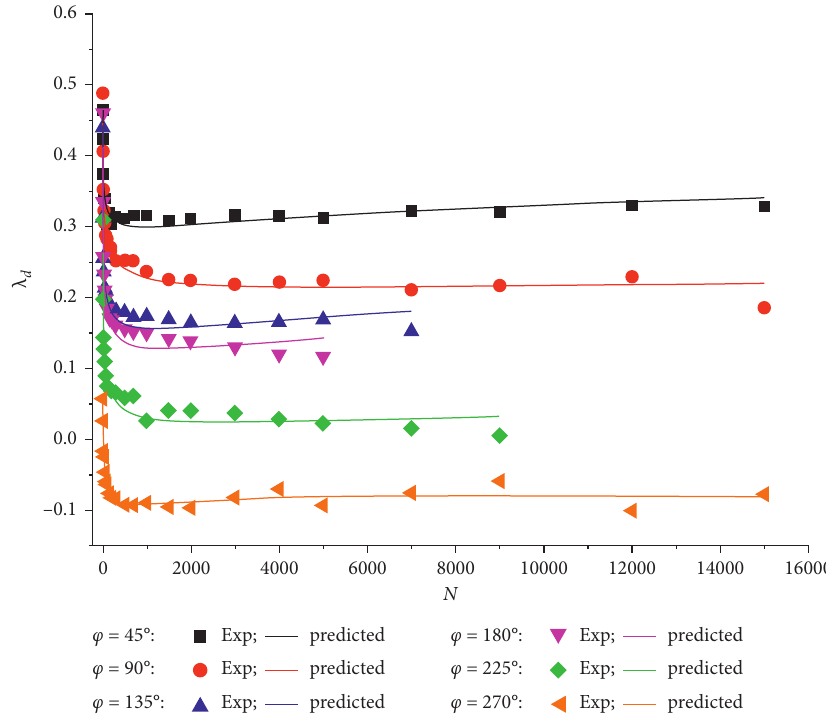
Figure 12: The relationship between damping ratios and number of load cycles with different phase differences.